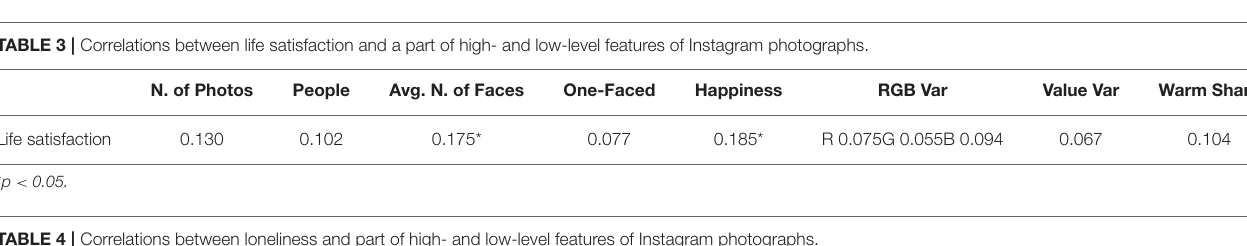
TABLE 4 | Correlations between loneliness and part of high- and low-level features of Instagram photographs. N. of Photos